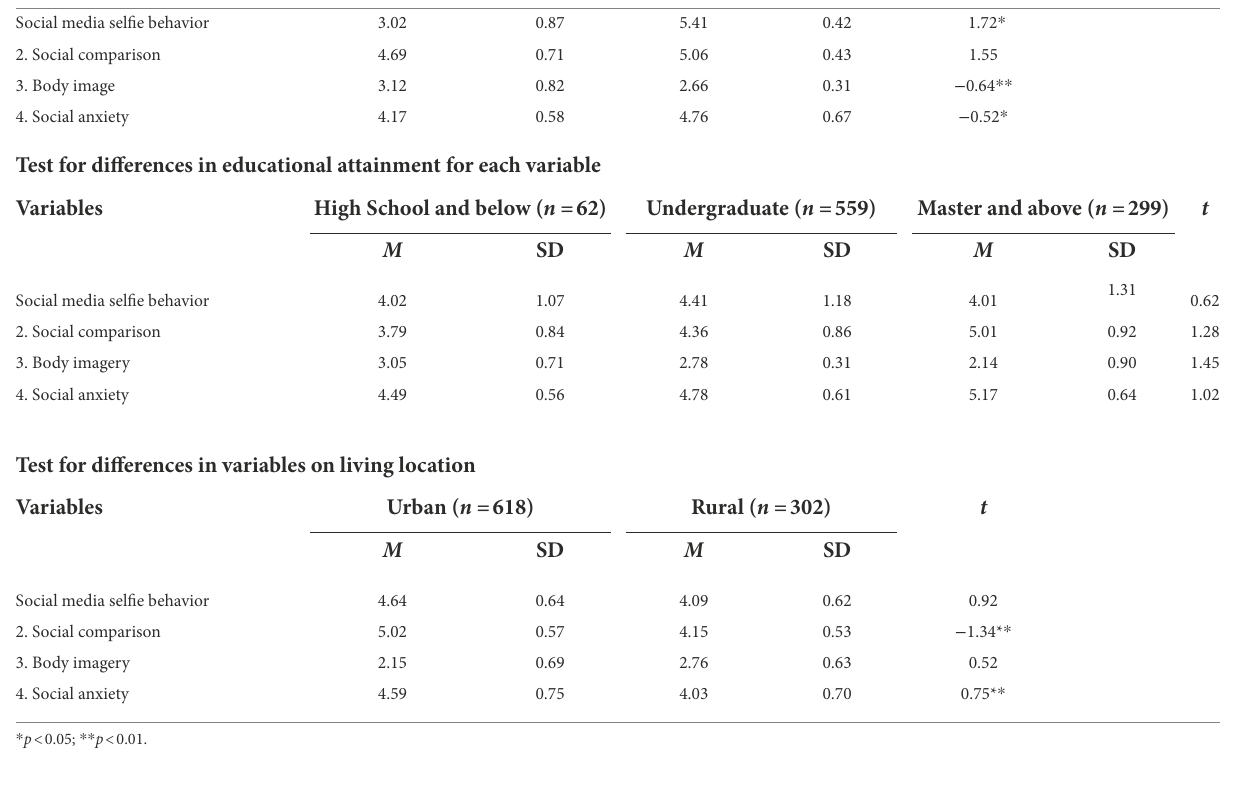
TABLE 5 Table of descriptive statistics results and variable correlations.